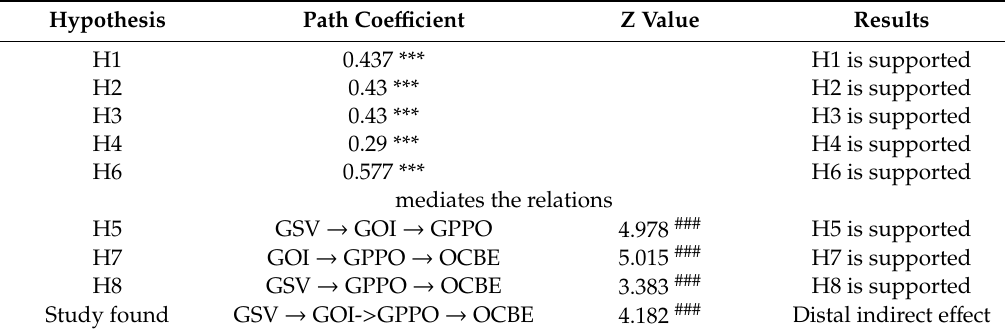
Table 7. Results of the structural